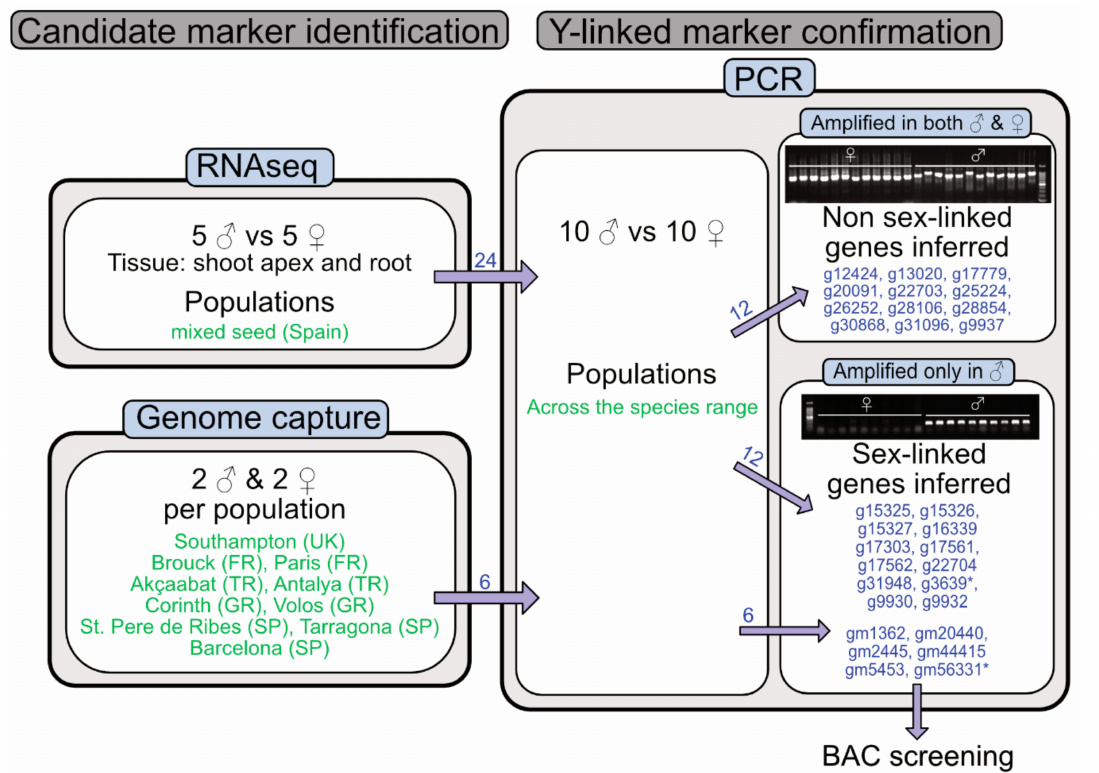
Figure 1. Graphical summary of diploid Mercurialis annua populations used, and the techniques we employed. Sampled populations are indicated in green, whereas polymerase chain reaction (PCR) products are indicated in blue. The PCR products marked with an asterisk represent the same sequence. The numbers next to the arrows indicate successful transcript attribution. The RNA sequencing (RNAseq) data come from [32], and the genome capture data from